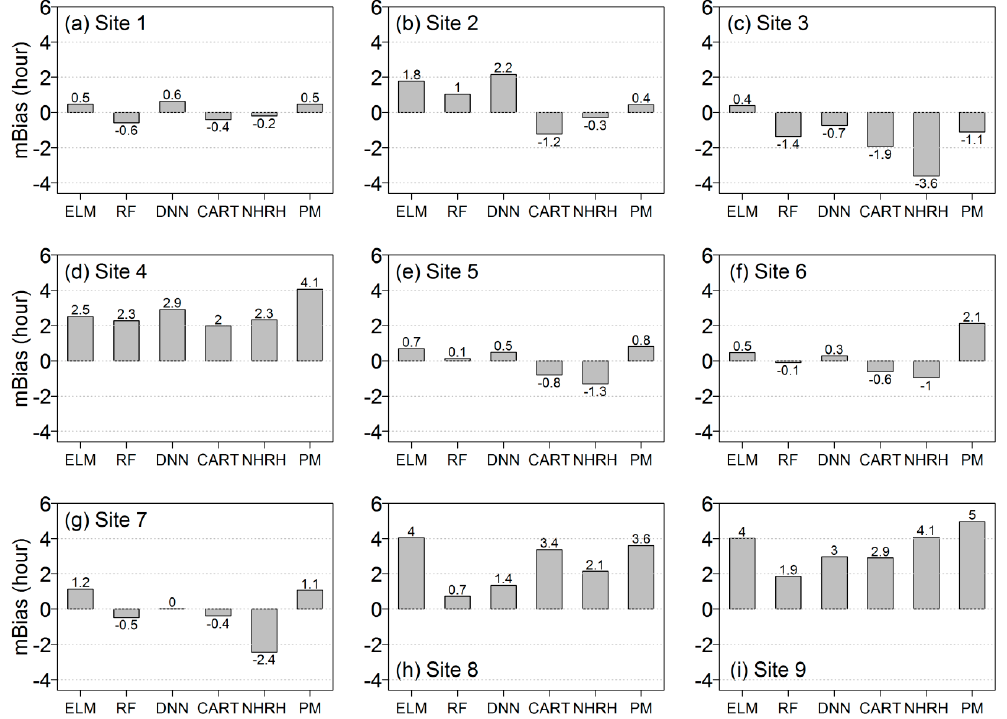
Figure 8. Mean bias (mBias) of the five LWD prediction models for all employed stations. Note that the used data sets are the same as those used in Table 3.